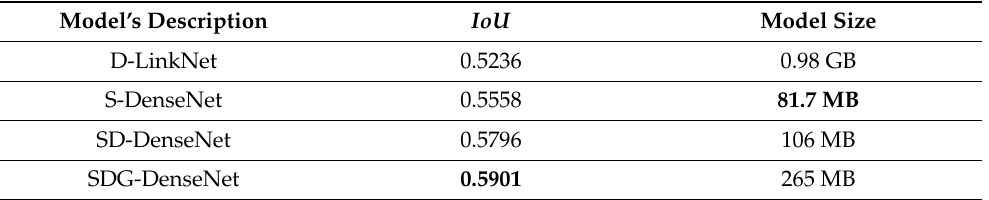
Table 5. Results of the Chongzhou–Wuzhen test set on different models. The bold font indicates the optimal value under the current evaluation